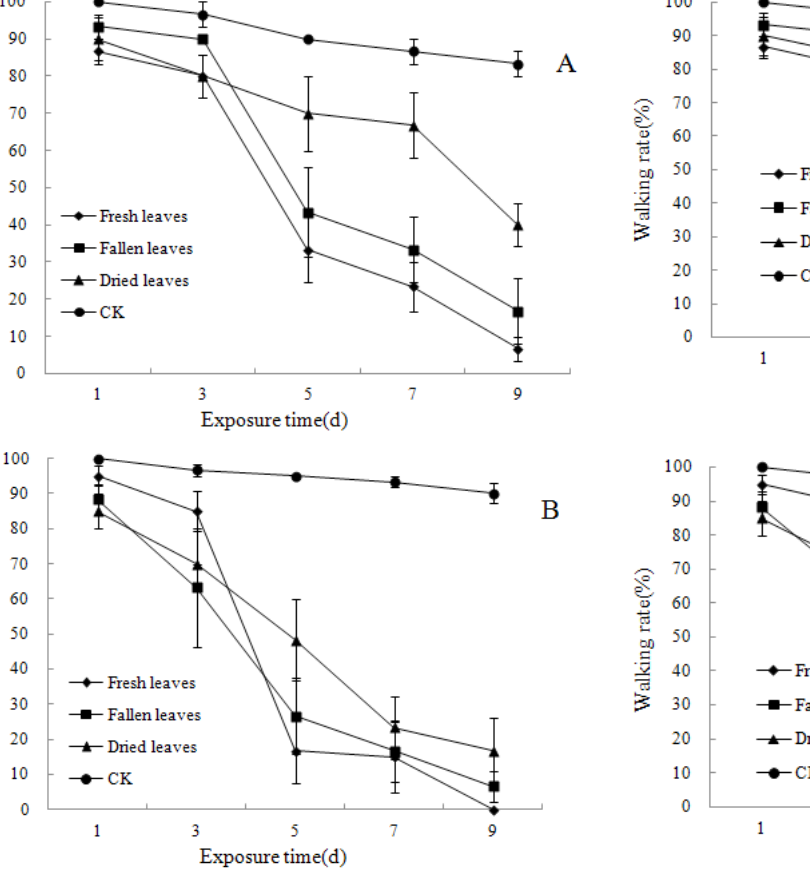
Fig 2. Effects on grasping ability of workers (A:major workers, B: Fig 3. Effects on walking ability of workers (A: major workers, B: Minor workers) after treated with different mashed leaves of M. exotica. minor workers) after treated with different mashed leaves of M. Table 2. Mortality of workers caused by mashed fresh, fallen, and dried leaves of M. exotica in the fumigation bioassay.